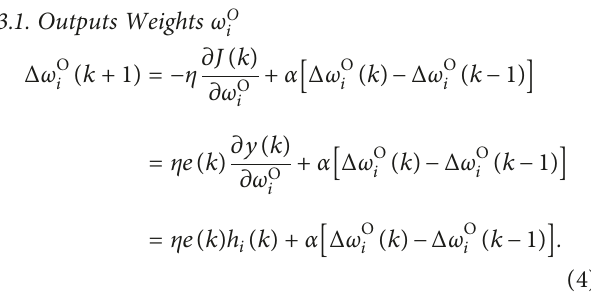
Figure 2: The structure of the FCNN by neurons B in the front layer which is known as the self- feedback of the logistic mapping unit.